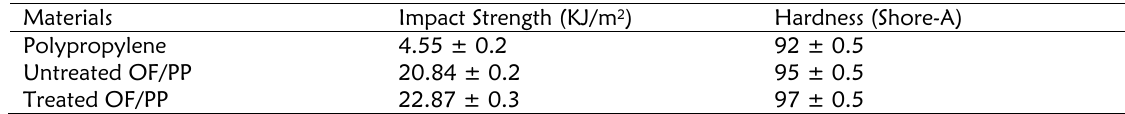
Table 2: Comparative impact strength and hardness of unreinforced PP sheet and the optimized composites (45% fiber content) found in this